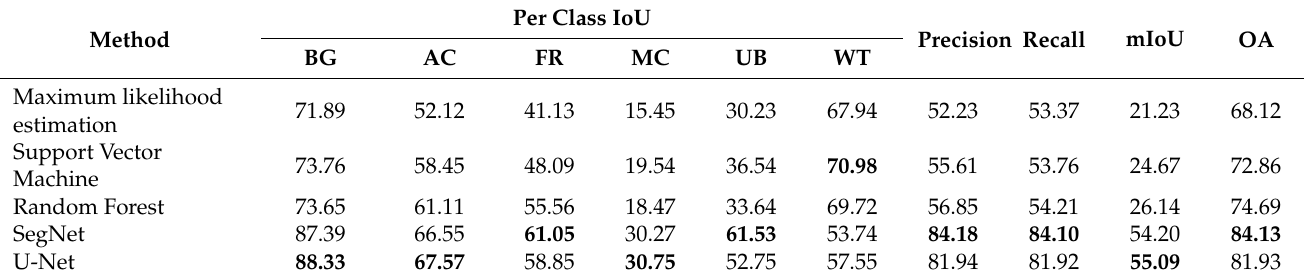
Table 2. The accuracy result (%) of pixel-based classification and deep learning semantic segmentation on the land use dataset. The highest values are highlighted in